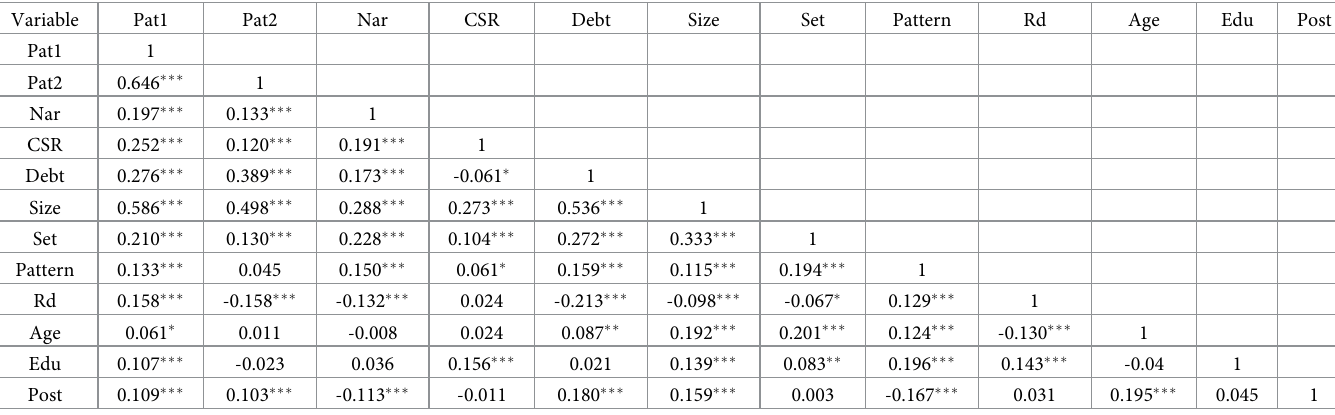
Table 4. Correlation coefficient test of each